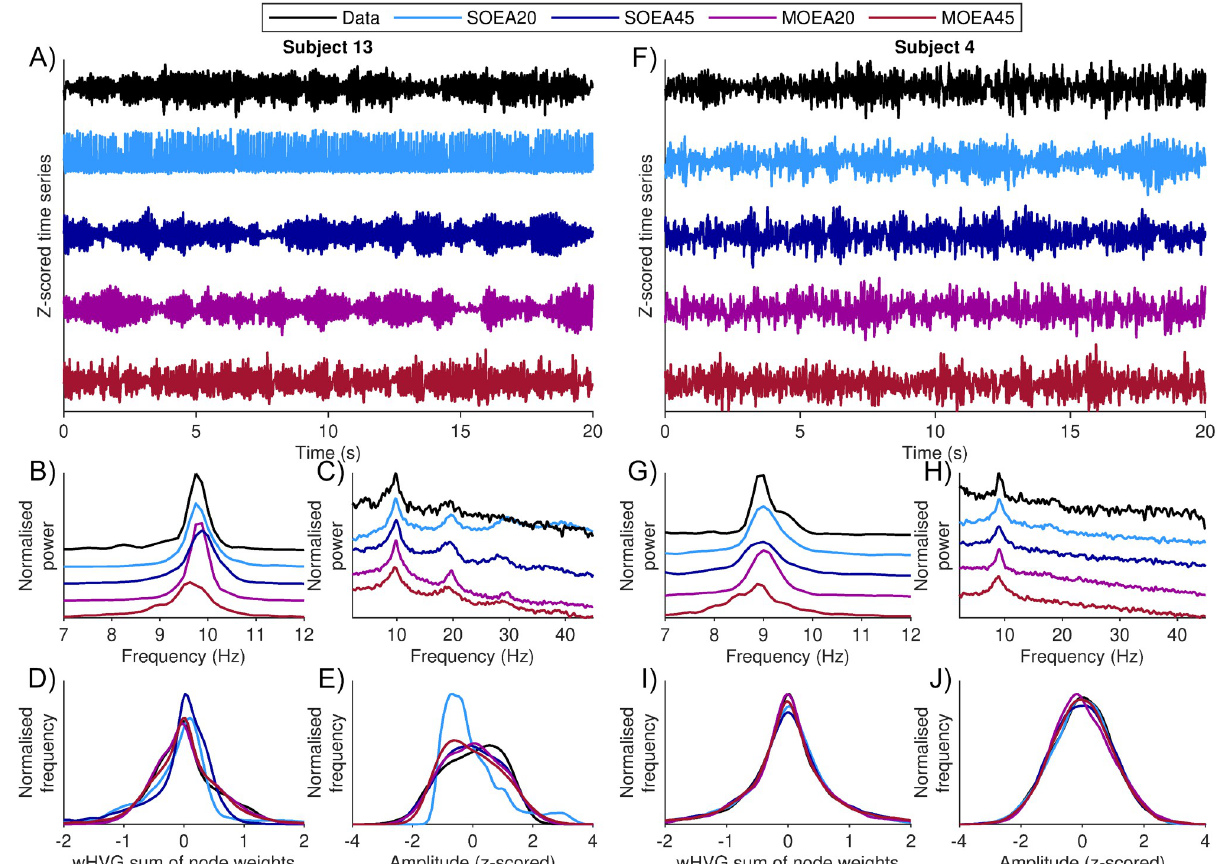
Fig 2. Two exemplar data sets and model output using optimal parameters derived from each algorithm. Optimal refers to the smallest Euclidean distance from the origin in objective space. A) time series from data (black) and model simulations from each algorithm (colours as per legend). The corresponding PSD for the data and each simulation is shown for B) the dominant alpha rhythm and C) the broadband spectrum. To better differentiate between the signals, the baseline of the normalised power is shown with an offset for each algorithm. D) and E) show the corresponding wHVG and amplitude distributions from each simulation against the data, respectively. In each case, these signals show a density approximation of the distribution, calculated from 100 equally sized bins (see Methods). F-J) shows the equivalent of A-E) for a second subject.